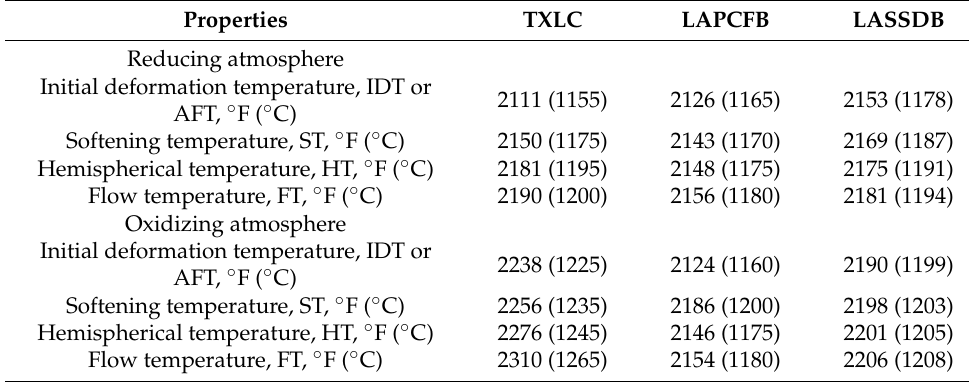
Table 5. Ash fusion behavior for reburn